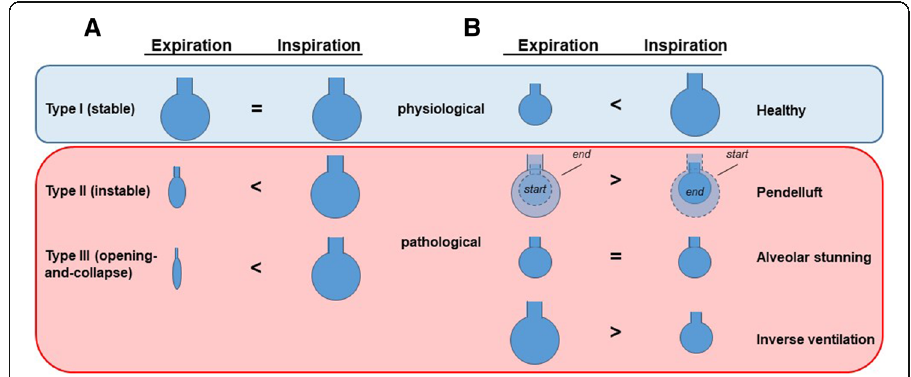
Fig. 3 Concepts of alveolar dynamics in injured lungs. a Classification of alveolar dynamics according to [115]. Alveoli which do not change in size between end expiration and end inspiration are considered stable (physiologic, type I), those which increase in size during inspiration are considered instable (pathological, type II), or may even show alveolar collapse (pathological, type III). b Classification of alveolar dynamics according to [116]. Expansion of the alveoli during inspiration is considered as normal alveolar dynamics (physiological, healthy), paradoxical motion of alveoli during both the end-inspiratory and the end-expiratory plateau phase is classified as pendelluft (pathophysiologic), no change of alveolar size during end expiration or end inspiration is classified as alveolar stunning (pathophysiologic), and a decrease of alveolar size during end inspiration is defined as inverse ventilation